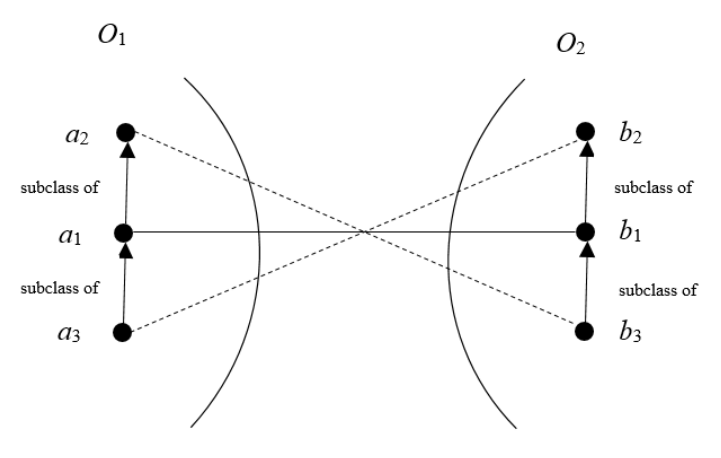
Figure 3. An example of inconsistent